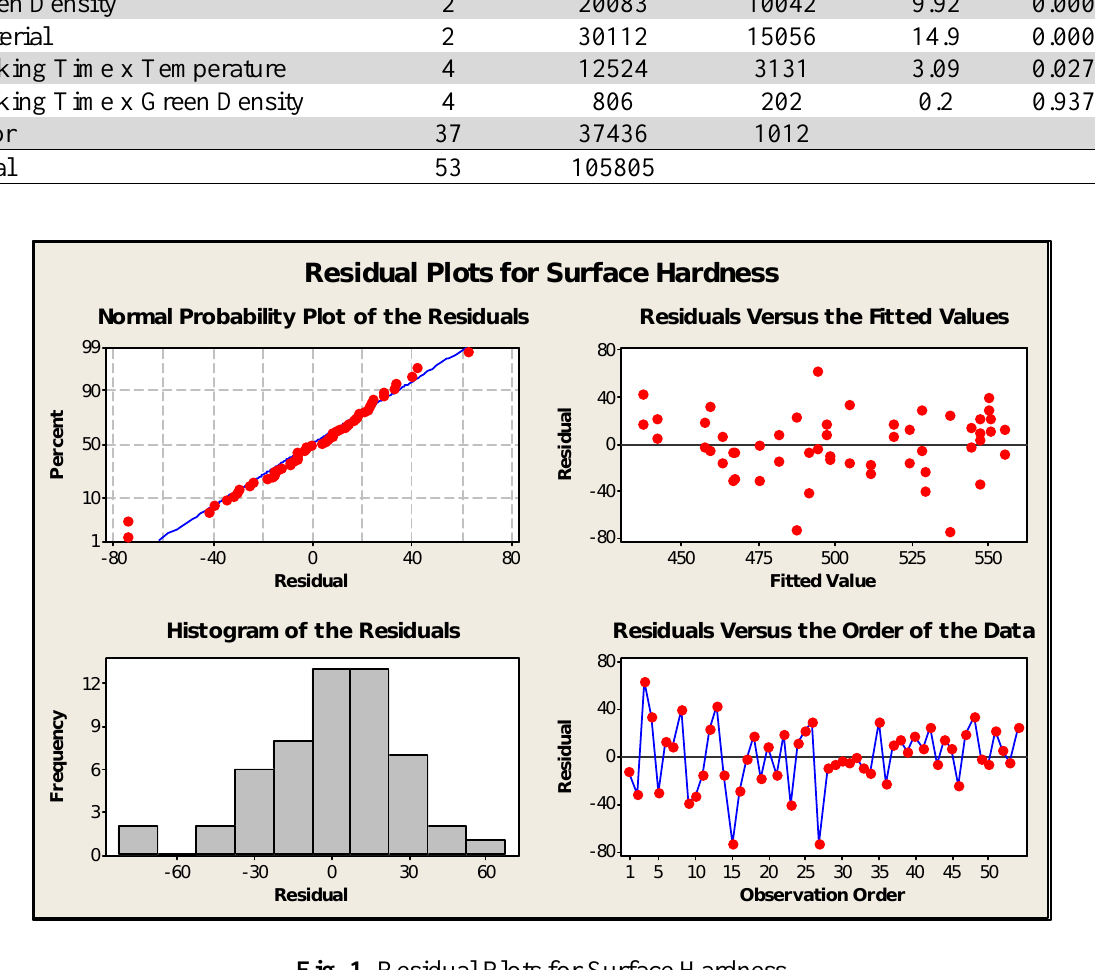
Fig. 1. Residual Plots for Surface